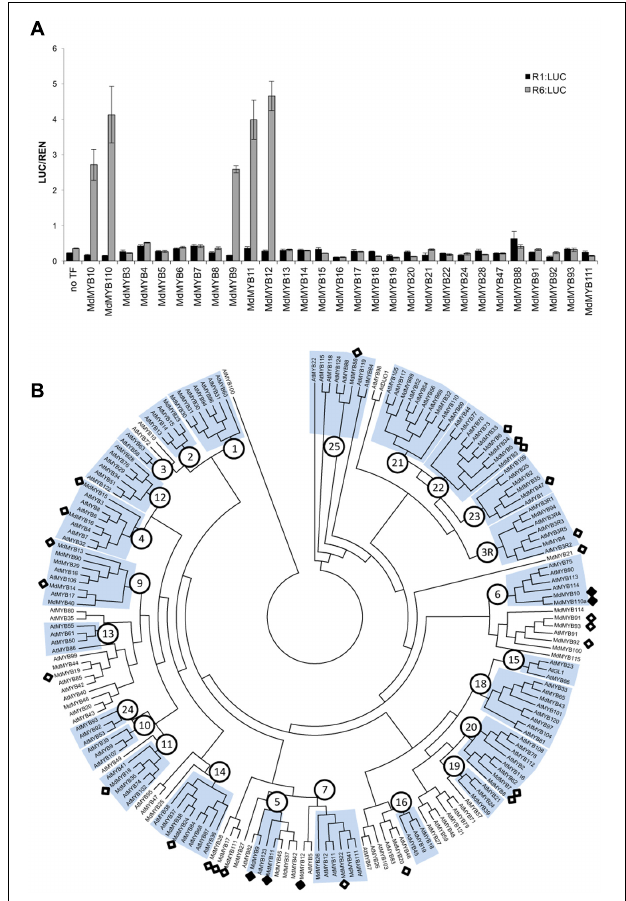
FIGURE 2 | Apple MYBs from subgroups 5, 6 and MdMYB12 can activate the R6-containing MYB10 promoter. (A) Apple MYB transcription factors (TFs) were co-infiltrated with MdbHLH3 and the MdMYB10-R1 pro : LUC or MdMYB10-R6 pro : LUC fusions (named R1:LUC and R6:LUC respectively) in N. benthamiana leaves and the LUC/REN signal was measured. Data represent means ( ± SE) of four technical replicate reactions. (B) Phylogenetic tree representing relationships between apple and Arabidopsis MYBs. Numbers indicate subgroups previously described for Arabidopsis MYBs (Stracke et al., 2001). Apple MYBs tested in transient assay in (A) (white diamond) and the MYBs tested positive for transactivation of the R6 promoter (black diamond) are indicated. Deduced amino acid sequences were aligned using CLUSTALX. Protein distances were calculated with PROTDIST using the Jones-Taylor-Thornton matrix and the tree was constructed by the neighbor-joining